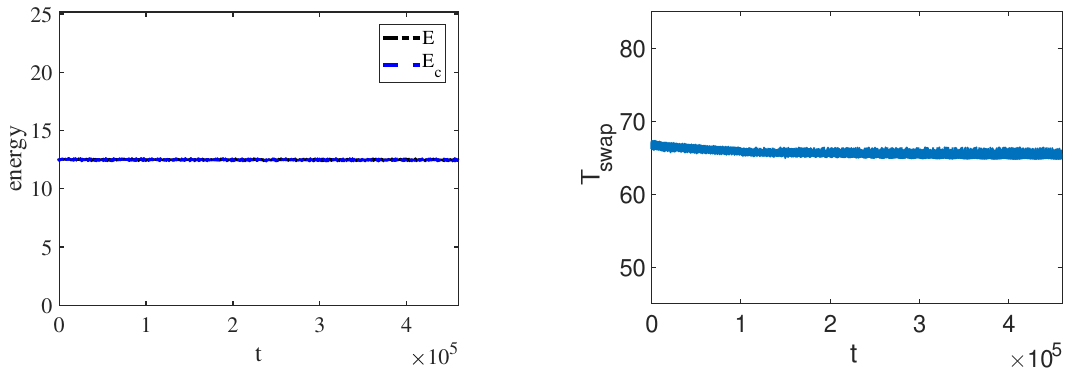
Figure 8 . Long term evolution of the energy and charge-swapping period of the logarithmic CSQ in 3+1D. The black line in the left plot, which is essentially invisible, is the total energy obtained by integrating the whole simulation box, while the blue line, denoted by E central region (see figure 2). Note that since we are only simulating the first octant, the energy in the left plot in only 1 / 8 of the CSQ’s total energy. This is achieved by about 1 . 1 × 10 5 CPU